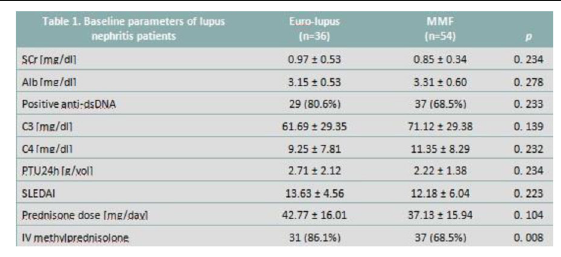
Table 1 (abstract O54). Baseline parameters of lupus nephritis